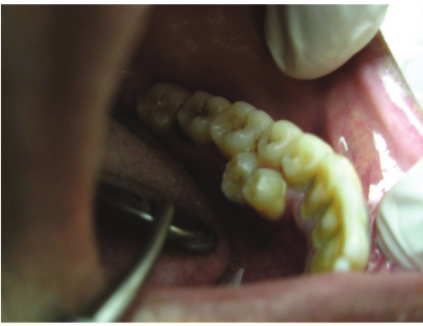
Figure 1: Supernumerary premolars presenting lingual to 34, 35.